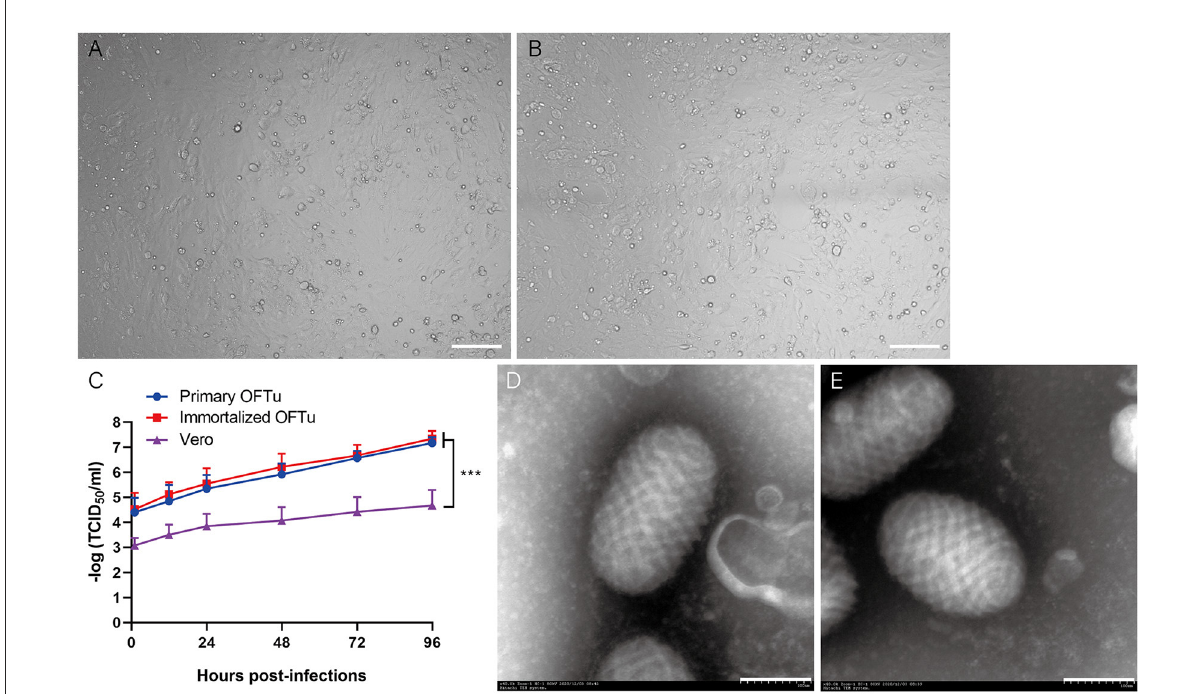
FIGURE5 ORFV can propagates in immortalized OFTu cell line. CPE of immortalized OFTu (A) and primary OFTu cells (B) after ORFV infection (MOI = 1). Scale bar = 100 µ m (C) Titer of ORFV gathered from primary OFTu, immortalized OFTu and Vero cells. Data are expressed as the means ± SD of the results of 3 separate experiments and analyzed by one-way analysis of variance (ANOVA) with uncorrelated Fisher LSD multiple comparisons test with GraphPad Prism 8, *** P < 0.001. TEM observation of ORFV virions gathered from primary OFTu (D) and immortalized OFTu cells (E) . Scale bar =